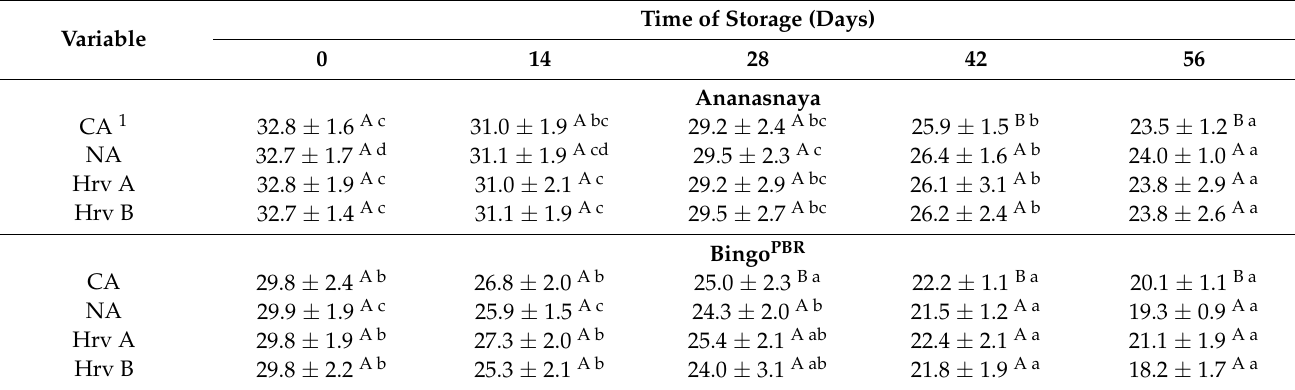
Table 7. Changes of skin colour [Chroma] measured in ‘Ananasnaya’ and ‘Bingo’ PBR minikiwi fruit in postharvest period. Variable